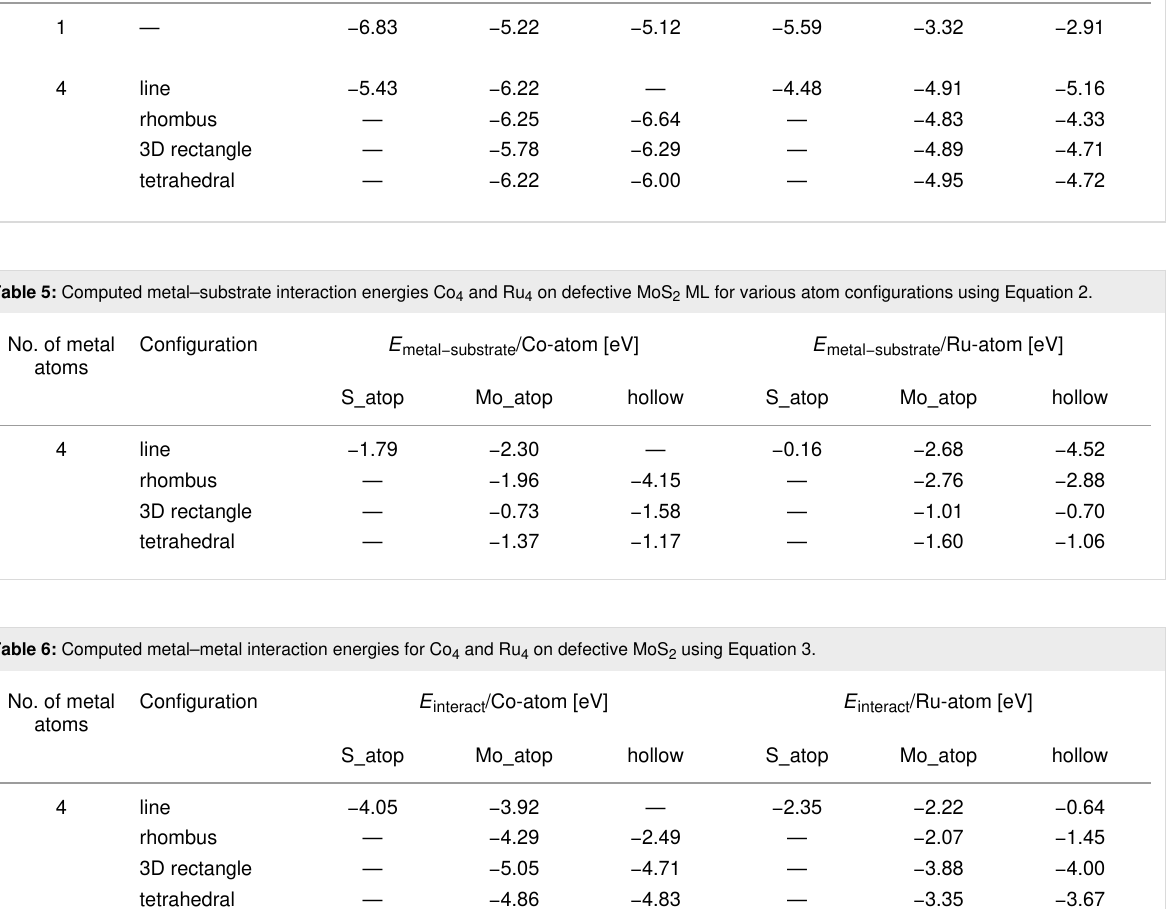
Table 4: Computed binding energies for Co 1 , Co 4 , Ru 1 and Ru 4 on defective MoS 2 ML for various atom configurations using Equation 1. No. of metal atoms